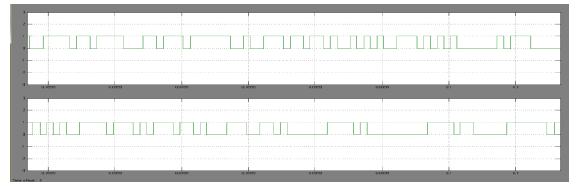
Fig. 20. Quadrature Data after Modulation.